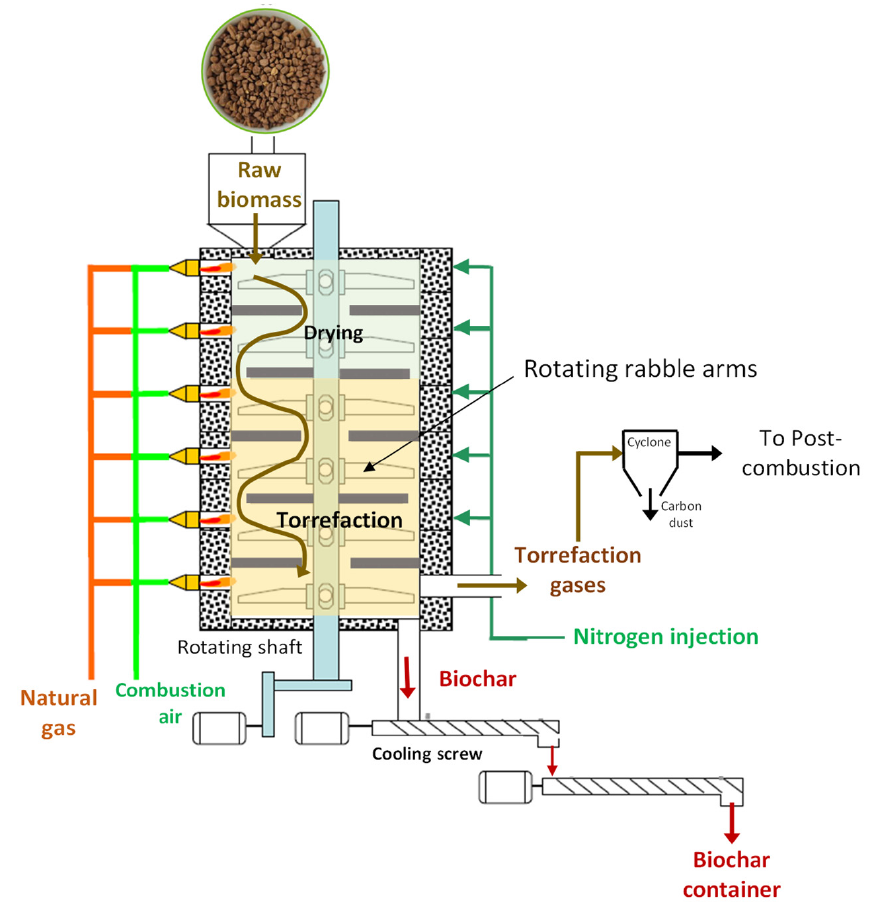
Figure 1. Scheme of the continuous torrefaction pilot plant (multiple-hearth furnace)